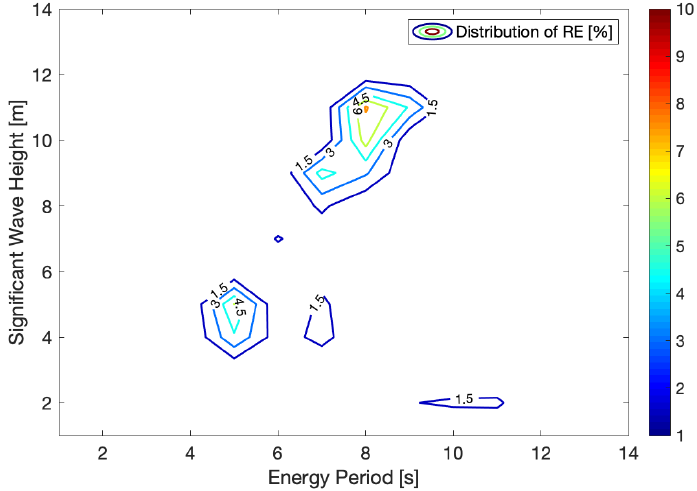
Figure 20. A comparison of annual energy production at Site 12 by the WEC under two types of damping control status: optimal damping and constant damping with a coefficient of 55 kNs/m (the presented numbers are in hundred percentage). Note that the calculation refers to Equation (9).